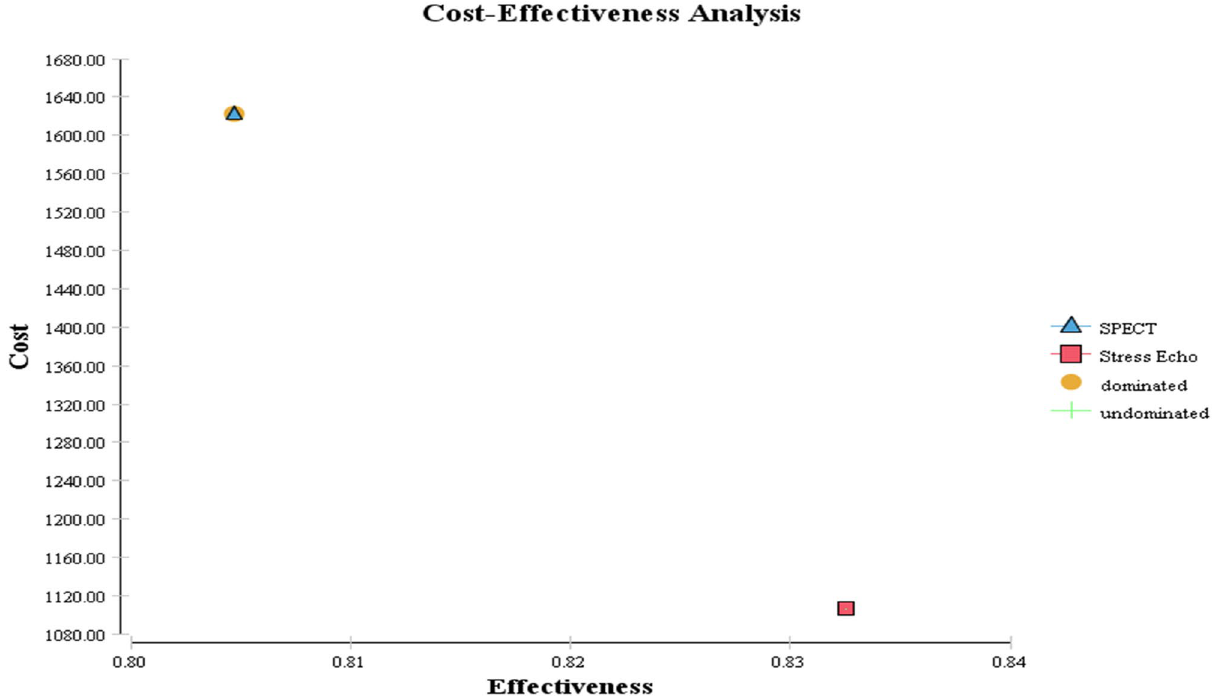
Figure 2. Cost effectiveness analysis of SPECT versus stress echocardiography.